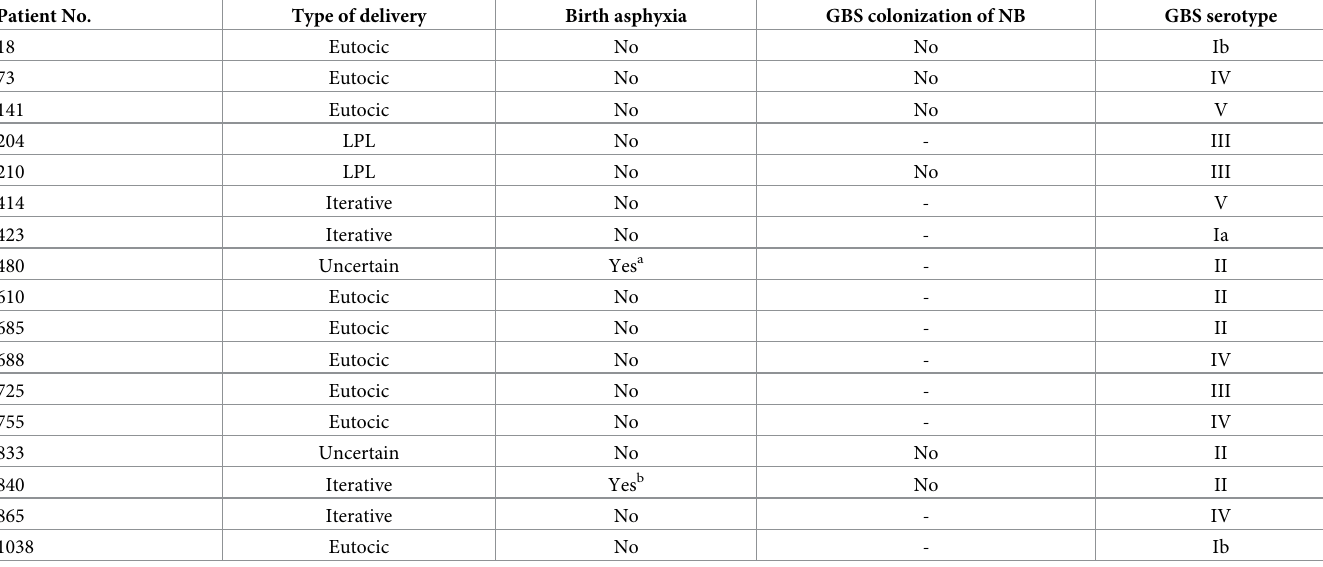
NB: Newborn; LPL: Caesarean section due to lack of progress in labor; Iterative: Iterative cesarean section; Uncertain: Cesarean section due to non-reassuring fetal status. a Use of balanced general anesthesia during surgery, Apgar